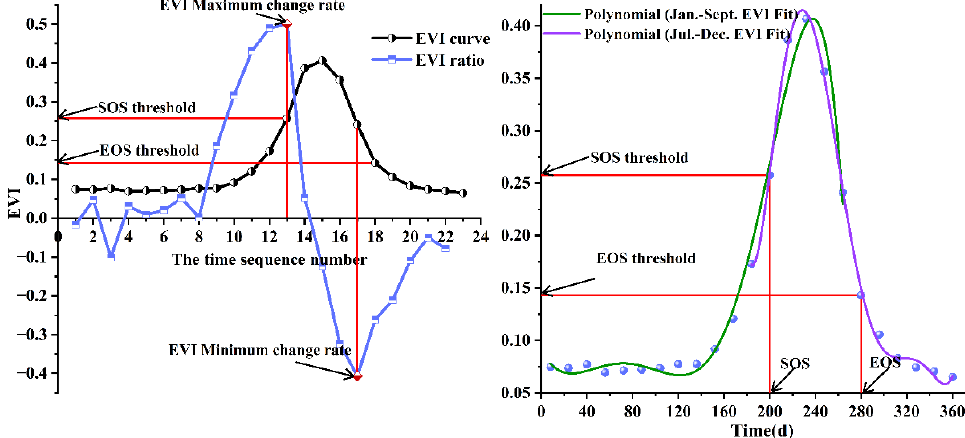
Figure 2. Methodology for extracting the SOS and EOS from the EVI seasonal